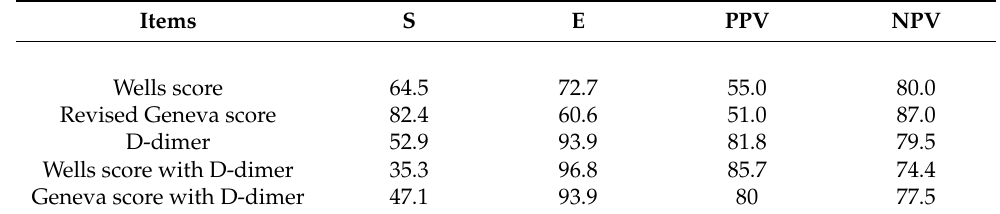
Table 4. Predictive values of the DD levels, Wells score, revised Geneva score and their combination to detect pulmonary embolism in elderly patients with COVID-19. Items S